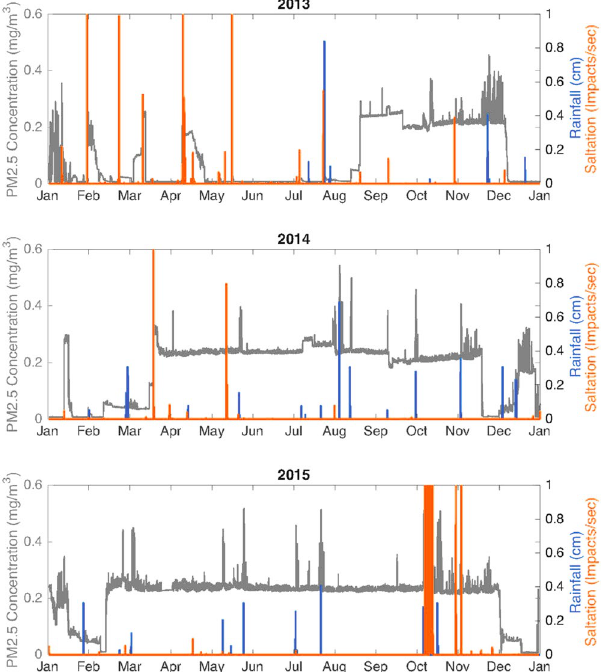
Figure 1. Time series of PM2.5 aerosol concentration, saltation, and precipitation at our field site in the Owens Lake salty playa in 2013, 2014 and 2015. These indicate that saltation events usually produce abrupt and large increases in aerosol concentration.